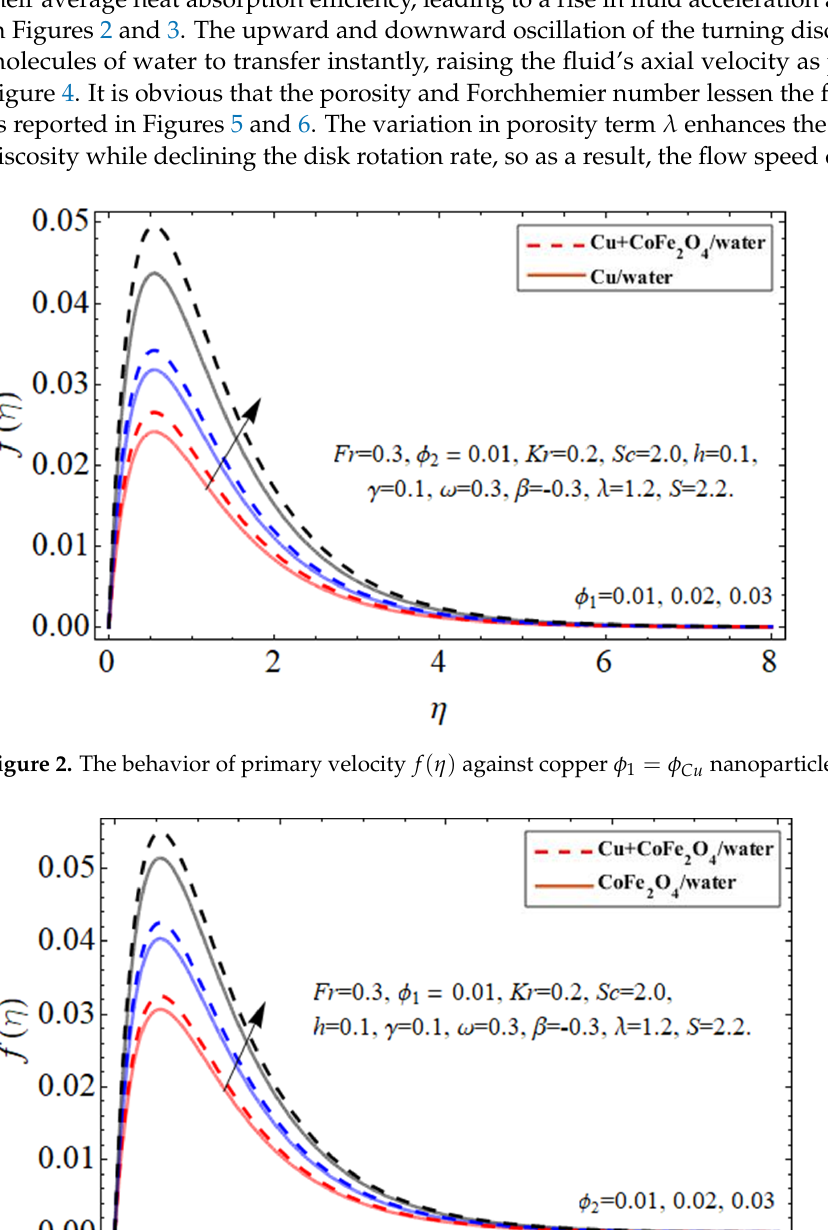
( ) η f against cobalt ferrite